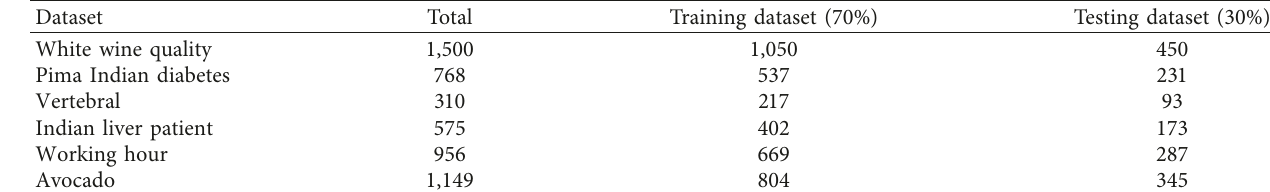
Table 1: Numbers of total, training and testing data points in six